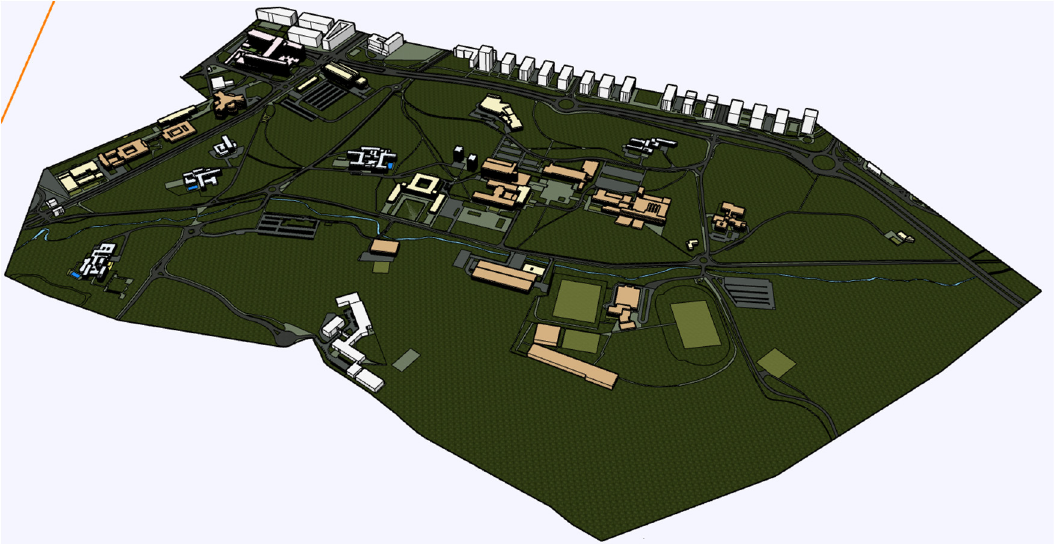
Figure 19. Final 3D model of the UNAV campus in Pamplona for simulation in NEST, (see Appen- dix